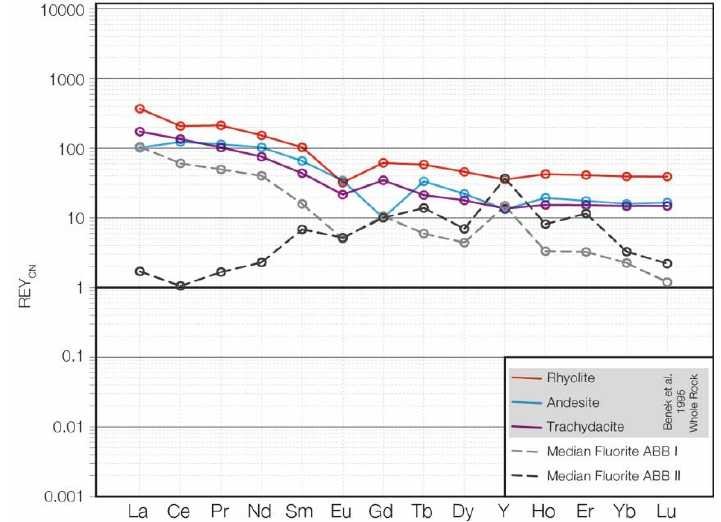
Figure 6. Comparison of C1 chondrite-normalized, [after 76] REY CN data for volcanic whole rock samples from the NEGB, [after 7] and the median fluorite signatures for generation I (AI, BI, CI, DI) and II (AII, BII, CII, DII) from the ABB (see also Figure 5.).